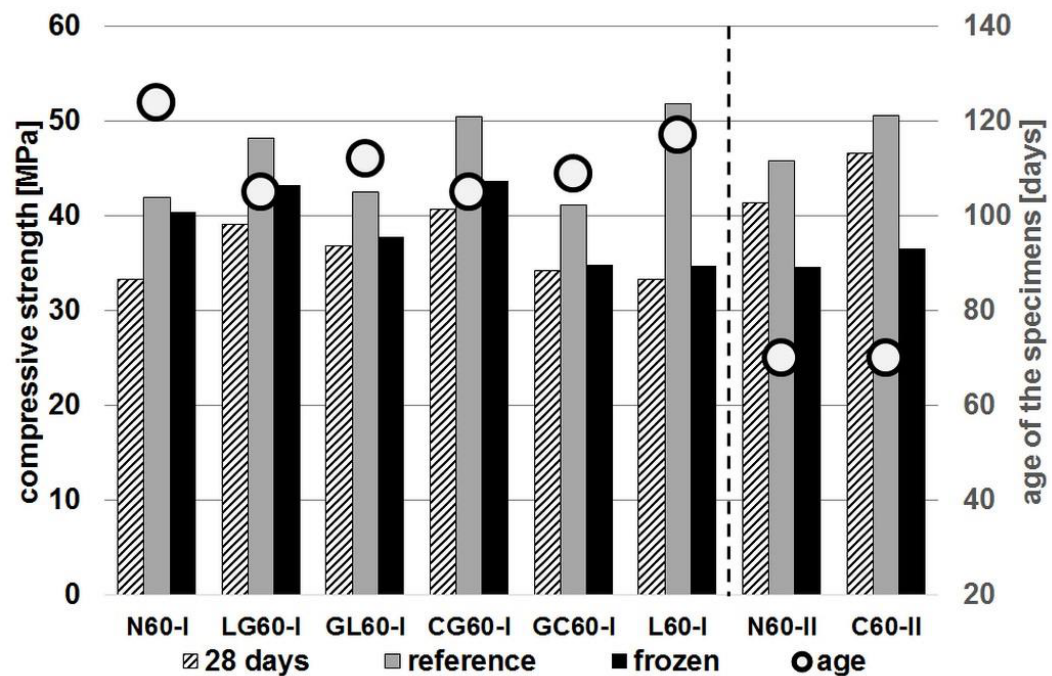
Figure 3. Results of frost resistance test (concrete series with w/c = 0.6).